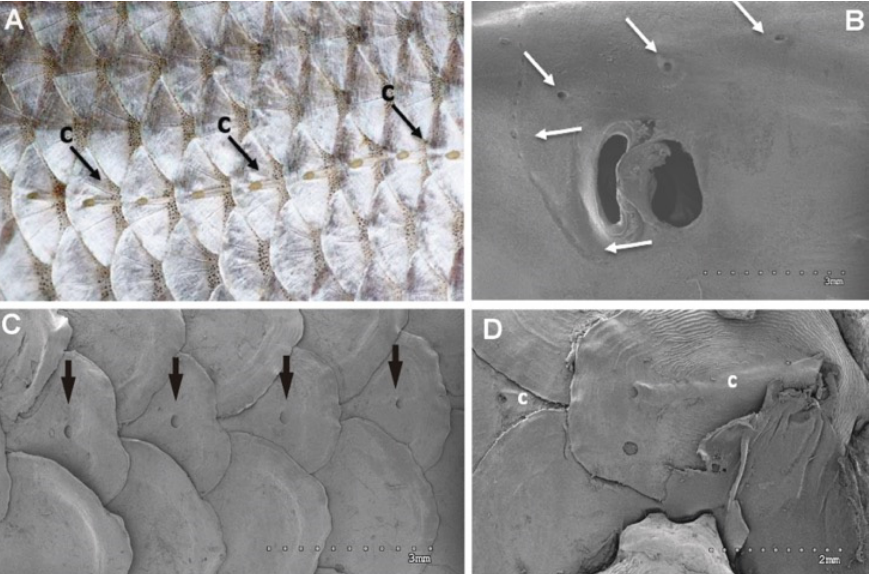
Figure 21. SEM. ( A ) Light microscopy (LM). ( B – D ): SEM. ( A ) Lateral line system located on the salmon scales of trunk (c signs the lateral line channel). ( B ) Lateral system located on the epithelium of the head (arrows). ( C ) Holes (arrows) of the channel of the lateral line system on the trunk. ( D ) Upper channel view on the scales (c). Scale bar: ( B , C ) = 3 mm. ( D ) = 2 mm.